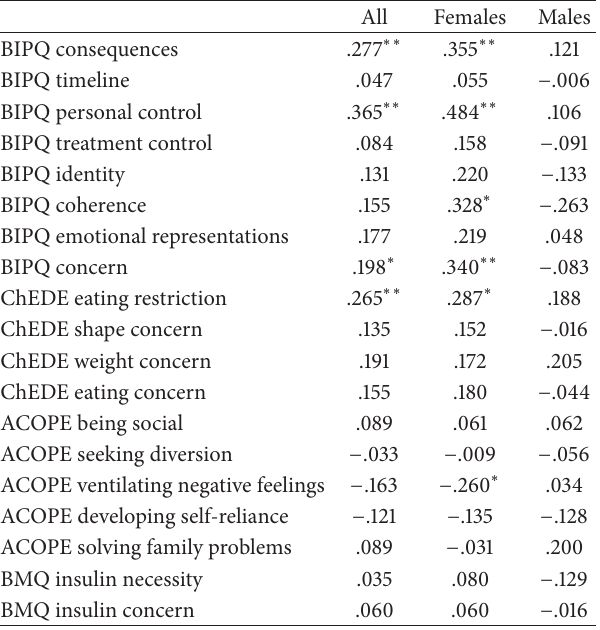
Table 1: Correlations between HbA1c and illness perceptions (BIPQ), eating disorder psychopathology (ChEDE), coping strate- gies (ACOPE), and insulin beliefs